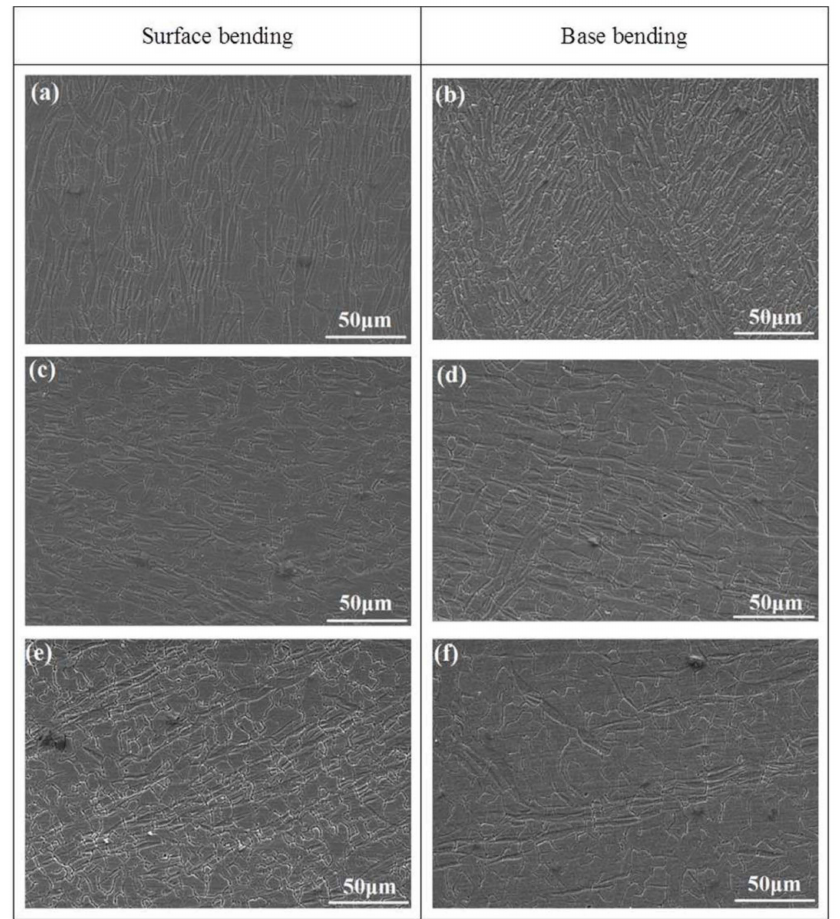
Figure 8. Microstructure in di ff erent region of the FSWed AZ31 Mg joint after surface bending and base bending with strain of 5% ( a , b ) region 1, ( c , d ) region 2 and ( e , f ) region